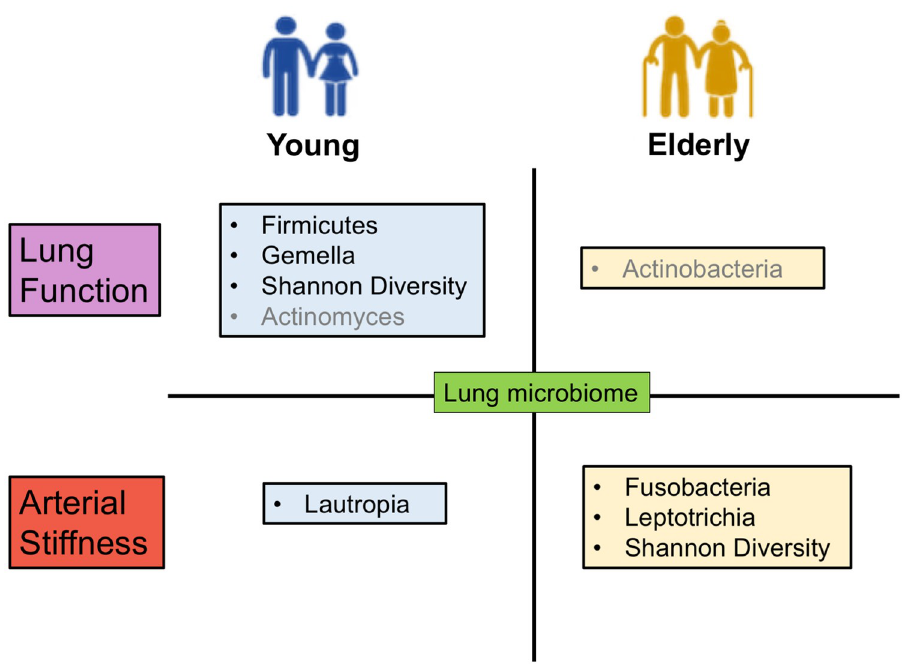
Fig 5. Summary schematic showing the significant associations between lung microbiome with lung function and arterial stiffness, within the young and elderly groups. Lung microbiome is associated with lung function mostly in the young group, as Shannon diversity, Firmicutes phylum and its genus Gemella are associated with predicted lung function, while absolute FEV1 is associated with Actinomyces (in grey). In the elderly group, absolute FVC is associated with Actinobacteria (in grey). Lung microbiome is associated with arterial stiffness mostly in the elderly group, with Shannon diversity, Fusobacteria phylum and its genus Leptotrichia associated with pulse wave velocity. In the young group, Lautropia is associated with arterial stiffness parameter augmentation